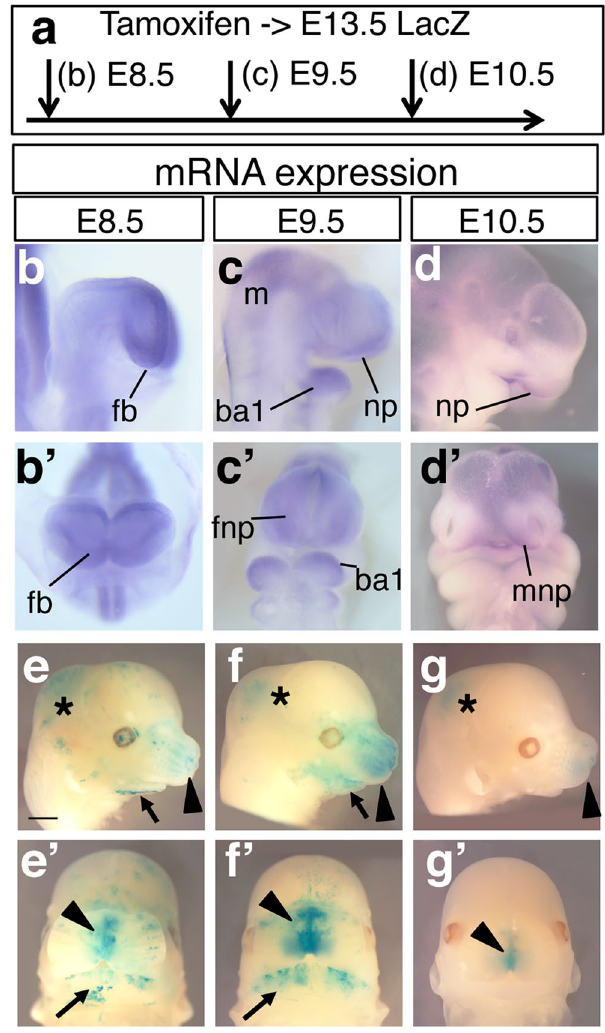
Figure 3. Sall4 lineage contribution to the craniofacial structures. Schematic of tamoxifen injections at different time points of embryonic development. ( b –d’) Lateral views ( b – d ) and frontal views (b’–d’) of Sall4 mRNA expression at indicated stages. ( e –g’) Lateral views ( e – g ) and frontal views (e’–g’) of LacZ stained E13.5 embryos. Asterisks indicate LacZ signals in the midbrain. Black arrowheads and arrows point to signals in the nasal region and the lower jaw, respectively. Abbreviations: ba1: branchial arch 1, fb: forebrain, fnp: front nasal process, m: midbrain, mnp: medial nasal process, np: nasal process. Scale bar in panel e: 1 mm. Panels e to g’ are in the same